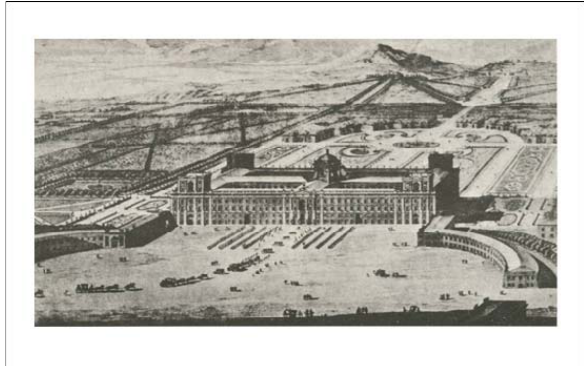
Figure 5. Vanvitellian complex: the original design of the building